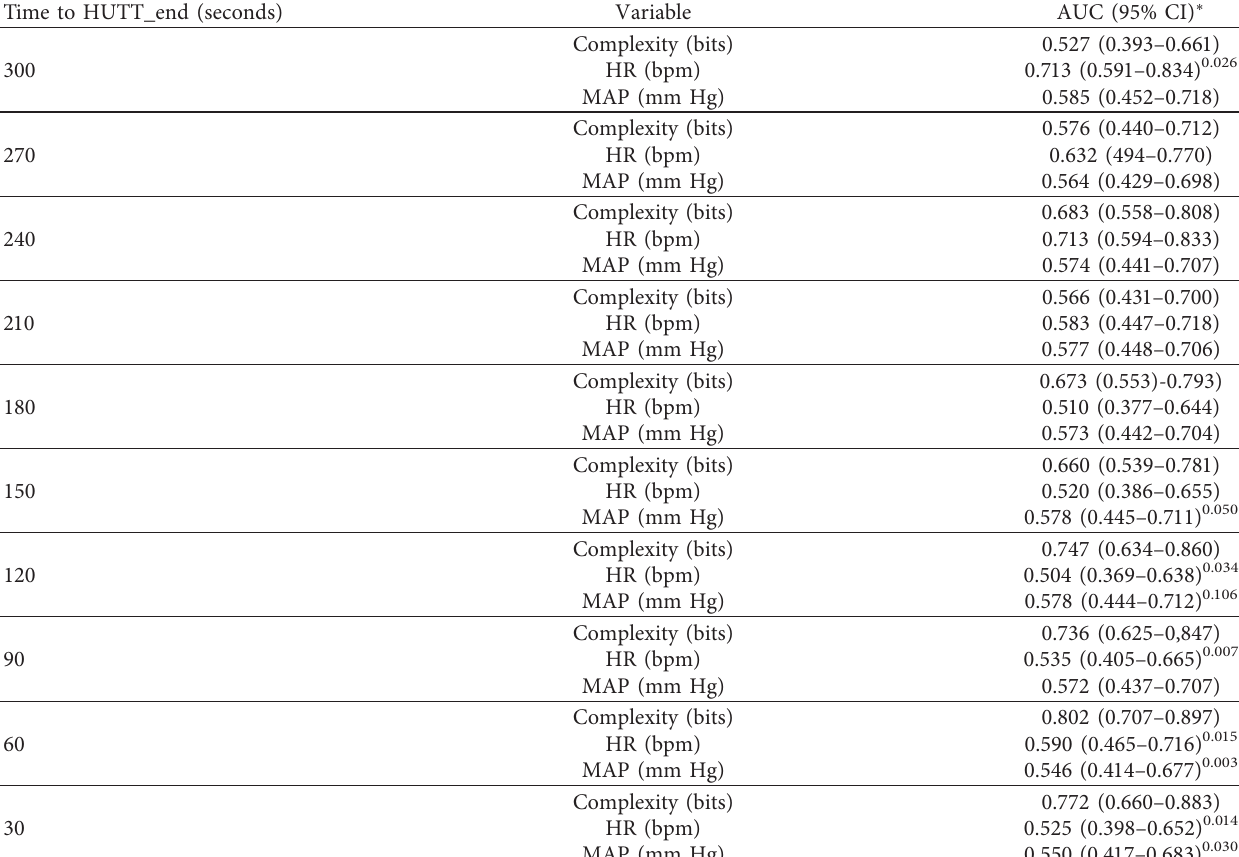
Table 3: Prognostic value of complexity, mean arterial pressure (MAP), and heart rate (HR) in the last 300 seconds before the termination of